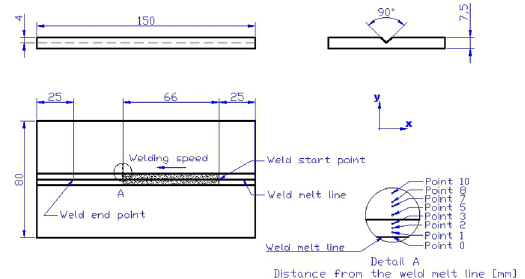
Figure 9. Layout of the specimen indicating points for thermal cycles. The zero point is found at the center of the weld melt line and 66 mm away from the initial welding point